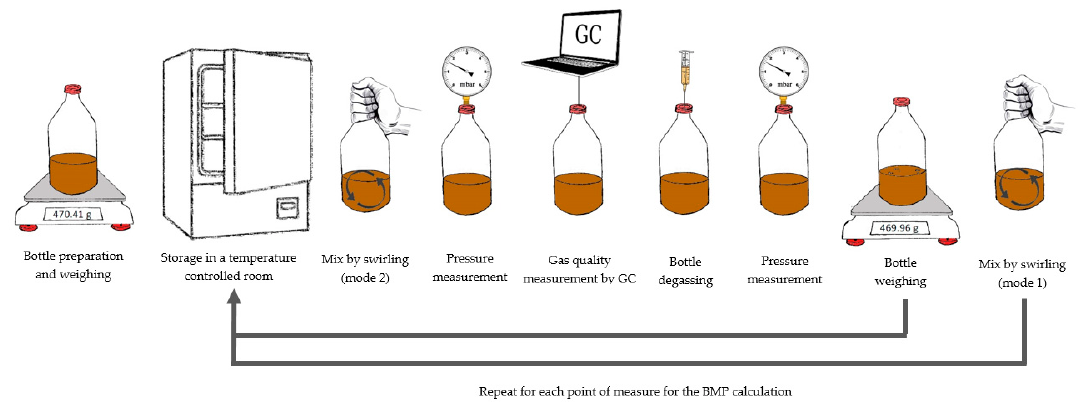
Figure 1. Sequence of steps used in the manometric and gravimetric tests for mixing modes 1 and 2.